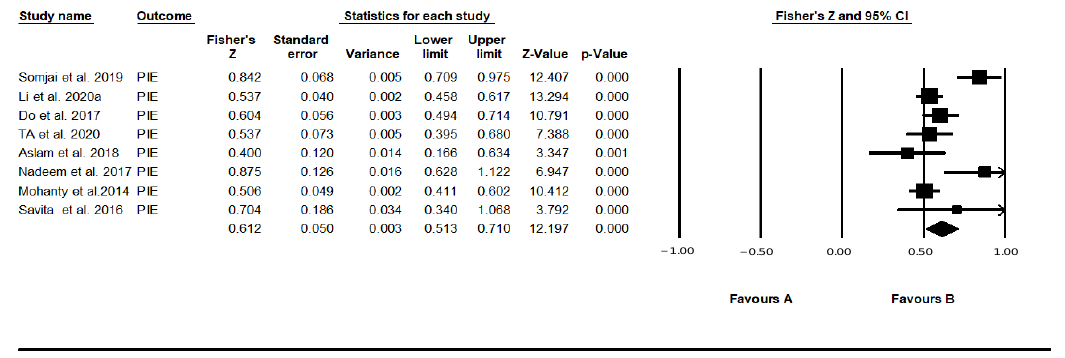
Figure 5. PIE forest plot after removing outliers.